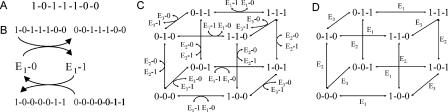
Structure of the Initial Network(A) Metabolites are assumed to consist of N different biochemical groups. Metabolites can be denoted as binary strings, because each group can be either present or absent. In the example given, the metabolite carries groups 1, 3, 4, and 5 whereas all other groups are absent.(B) Enzymes catalyze the transfer of specific biochemical groups between metabolites. For the group transfer we assume a ping-pong–like mechanism that consists of two half-reactions. In the first half-reaction, the group is transferred from a donor to the enzyme. Thereby the donor is transformed into its corresponding acceptor. In the second half-reaction, the enzyme transfers the group to another acceptor, thereby transforming it into its corresponding donor. We assume that a half-reaction follows linear reversible kinetics. This results in Michaelis-Menten–like kinetics for the transfer of a group from one metabolite to another. For the initial network we assume that enzymes are specific with regard to the group but unspecific with regard to donors and acceptors, i.e., they transfer a specific biochemical group from any donor to any acceptor.(C) The initial network consists of 2N metabolites. A single half-reaction transforms the metabolites into one of the N neighbours, such that the initial network resembles an N-dimensional hypercube. Note, however, that for the transfer of a group, two edges (i.e., half-reactions) in the cube have to be coupled.(D) To study the impact of group transfer on the connectivity distribution of the simulated networks, we performed simulations with monomolecular reaction networks, in which groups are added and removed, but not transferred, by the enzymes. The initial network has a similar structure. However, in contrast to the group transfer network, each reaction can be performed without coupling to another reaction.